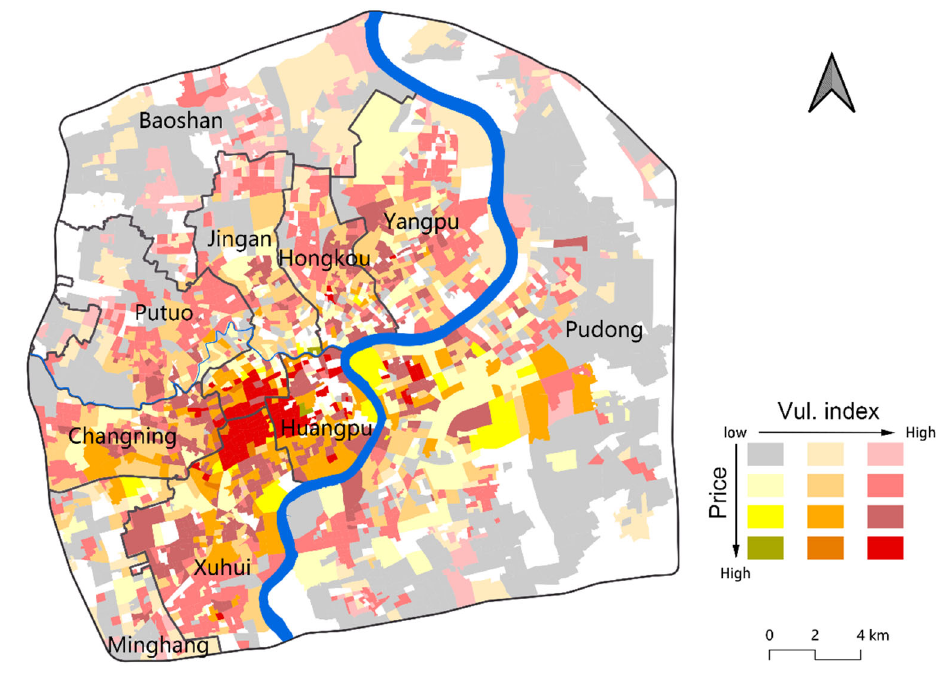
Figure 11. Bivariate depiction of the vulnerability index and house unit price.